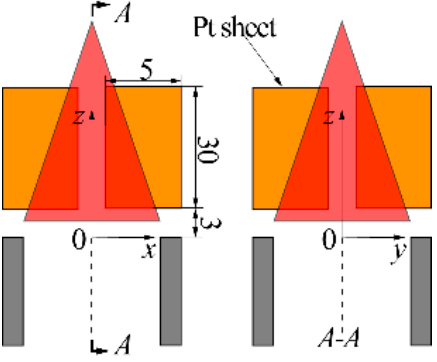
Figure 19. Schematic of the electrode structure with the added sheet cathode. The comparison of the I signals collected by the original (with the suggested sensor parameters) and improved (with the sheet cathode) sensors are displayed in Figure 20. The . Q four subgraphs in the figure correspond to = 50 L/h, 100 L/h, 150 L/h, and 200 L/h. f The black and red lines refer to the original and improved sensors, respectively.